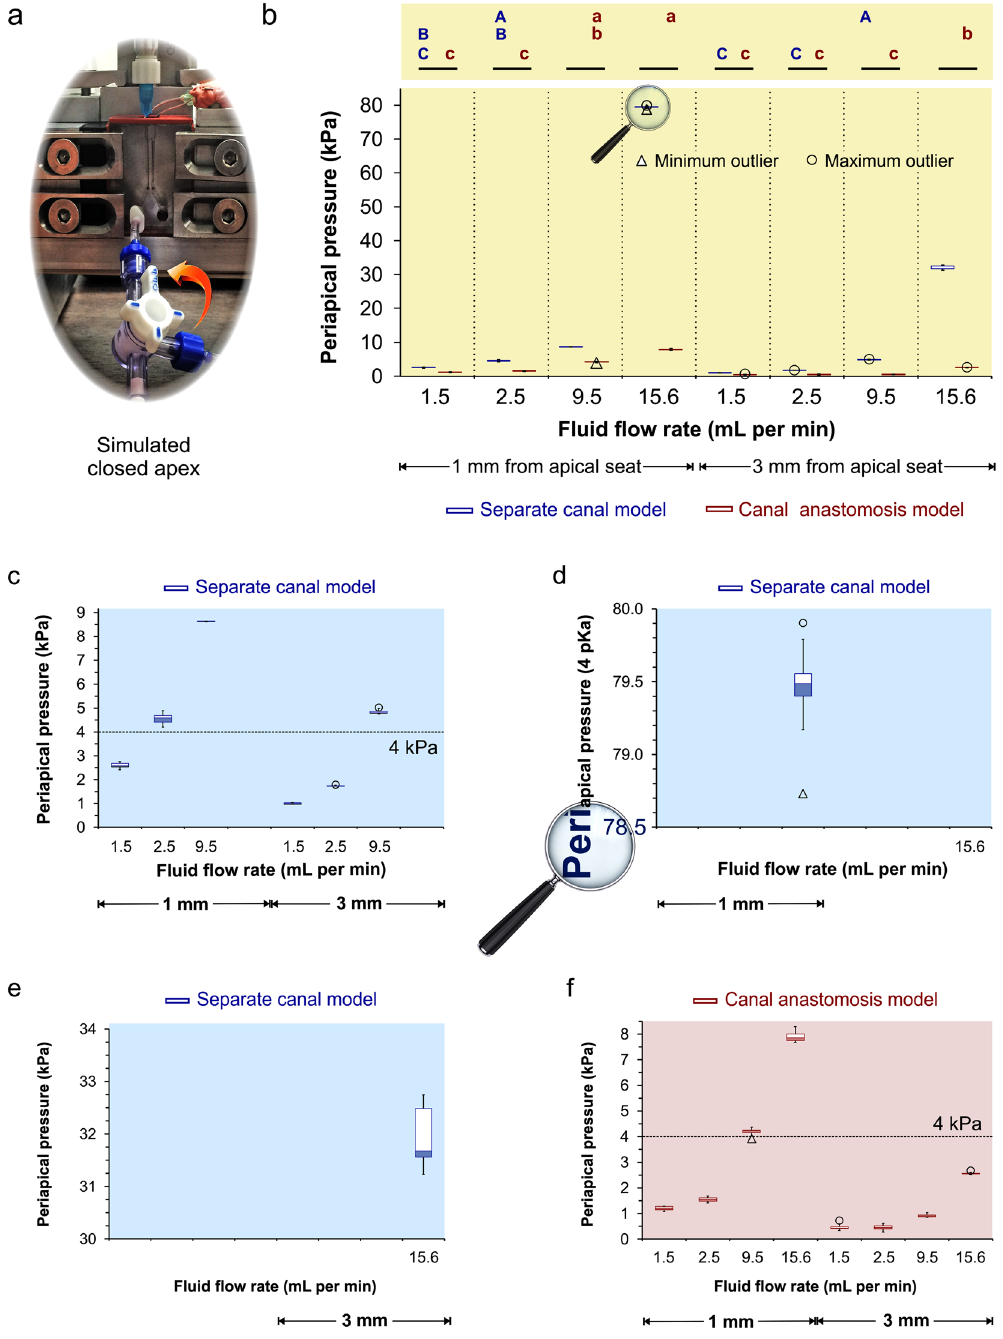
Figure 6. Data analysis. ( a ) A closed-canal system was produced in the experimental models to enable detection of periapical pressure build-ups by the pressure sensors. ( b ) Overview of box-and-whisker plots of pressures generated by the two models. For pairwise comparisons within the separate canal model, groups identified with the same upper-case letters are not significant different (p > 0.05). For pairwise comparisons within the canal anastomosis model, groups identified with the same lower case letters are not significant different (p > 0.05). For inter-model comparisons, groups identified with a green bar are significant different (p < 0.05). ( c ) High magnification of the separate canal model plots for 1.5, 2.5 and 9.5 mL/min fluid flow rates at 1 and 3 mm from the apical termination. Values are medians and quartiles. The dotted line at 30 mm Hg represents intraosseous space blood pressure. ( d ) High magnification of the separate canal model plot for 15.6 mL/min at 1 mm from the apical terminus. ( e ) High magnification of the separate canal model plot for 15.6 mL/min at 3 mm from the apical terminus. ( f ) High magnification of the box-and-whisker plots in the canal anastomosis